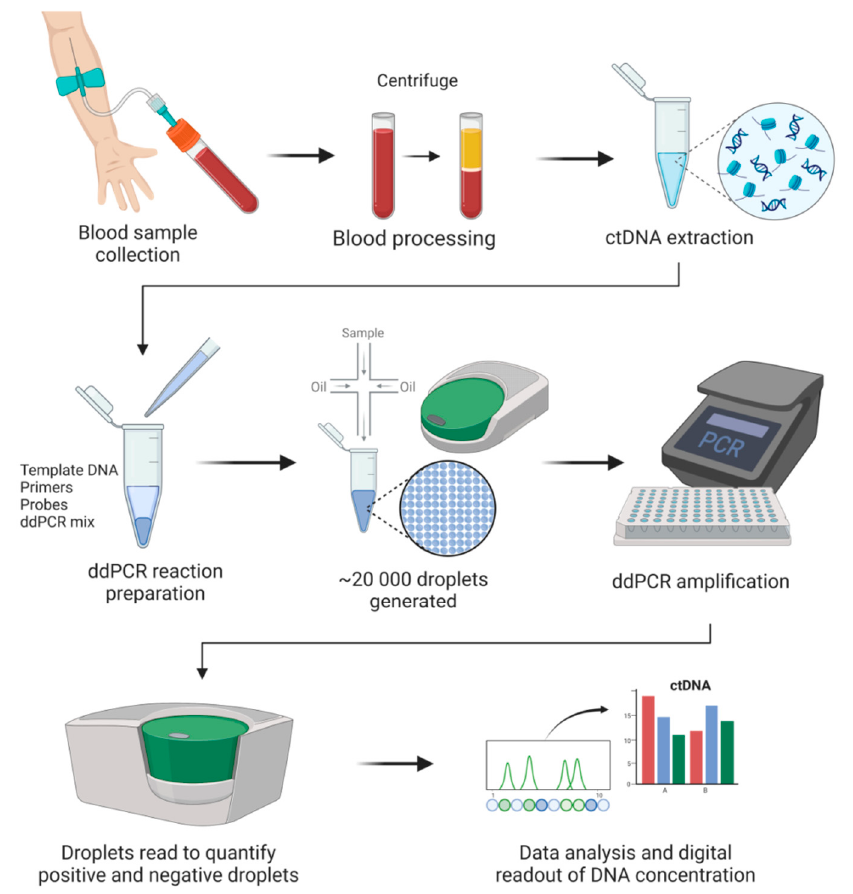
Figure 1. General digital droplet PCR (ddPCR) workflow in cancer liquid biopsies. DNA quantification by ddPCR is based on limiting dilutions, PCR, and Poisson distribution. As the next generation of PCR technology, ddPCR enables absolute quantification of target molecules in a sample by partitioning the reaction with high precision and accuracy. In ddPCR, template molecules in a reaction are first randomly partitioned into a large number (~20,000) of separate PCR sub-reactions, in which each partition or droplet receives either no template or one or more copies. Amplification occurs in those partitions containing any number of target molecules (positives), and no amplification is detected in those partitions with zero copies of target molecules (negatives). After PCR, the number of droplets with negatives and positives is counted based on the fluorescence amplitude. Sample partitioning results in the enrichment of target molecules within the isolated drops, and this enrichment effect limits template competition. In this way, the detection of rare variants in the presence of high background of wild-type sequences is enabled. The concentration of the target nucleic acid is calculated by Poisson statistical analysis without the need for a standard curve [71]. Due to the inherent stochasticity of partitioning, the fluorescence signals produced during amplification generate a Poisson distribution. The fraction of amplification-positive partitions is used to calculate the con- centration of the target sequence or variant allele. ddPCR has many applications, mainly mutation detection and copy number variation [72]. ddPCR offers many advantages, e.g., greater precision and sensitivity for the detection of low copy variants and high tolerance to inhibitors [65,73]. More importantly, the ability of ddPCR to facilitate a calibration-free quantification represents a superior advantage over qPCR